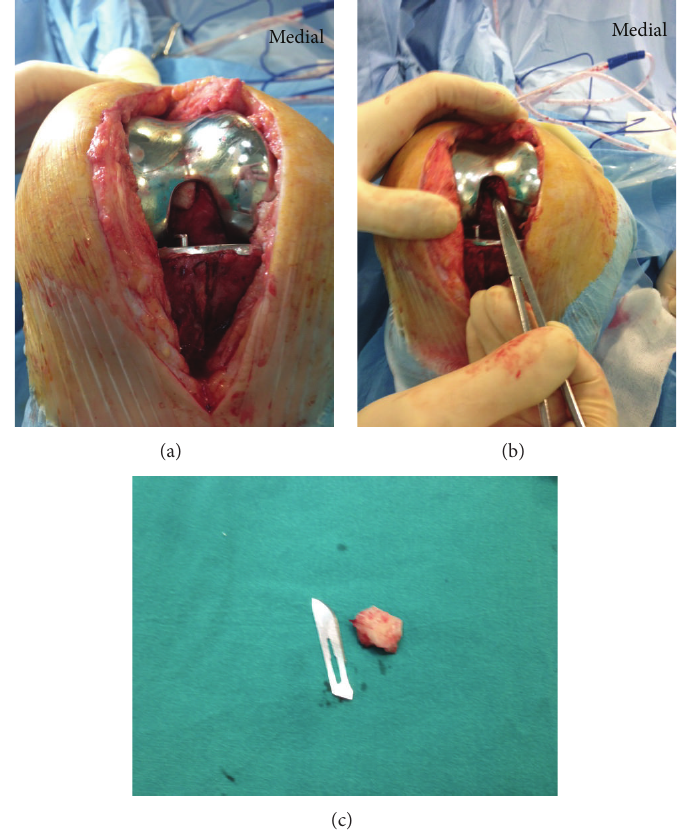
Figure 2: A large cement part extruded into intercondylar notch impinging PCL was seen intraoperatively (a), following removal of cement, PCL was relaxed (b), and the removed part of cement is seen on